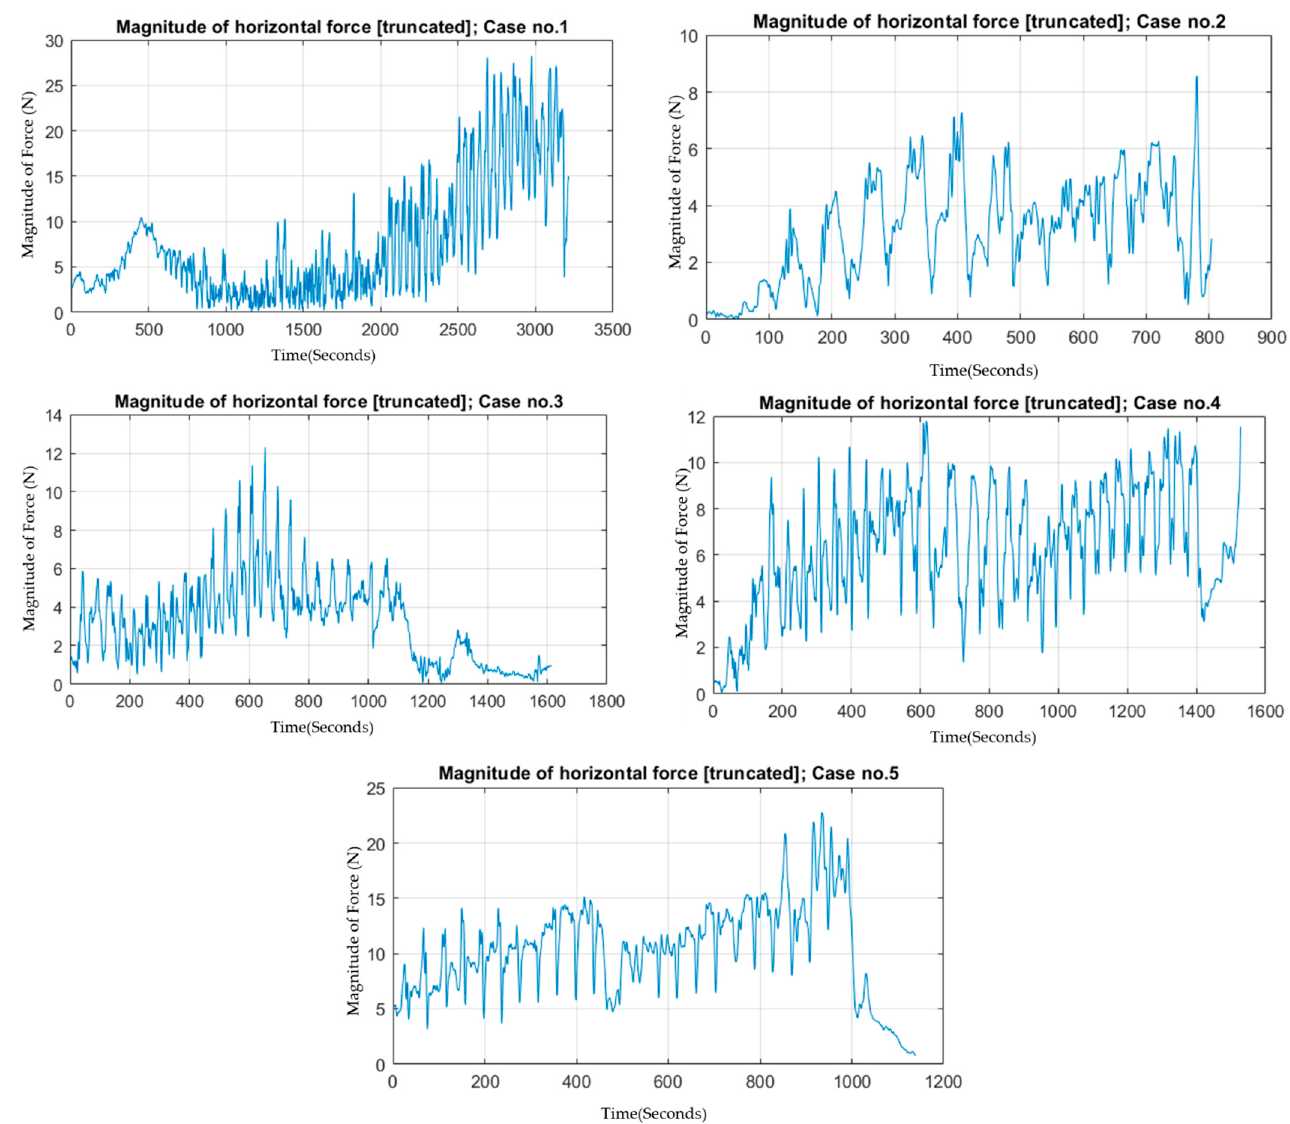
Figure 5. Magnitude of horizontal force including force on x-axis and y-axis according to time of action of each case.